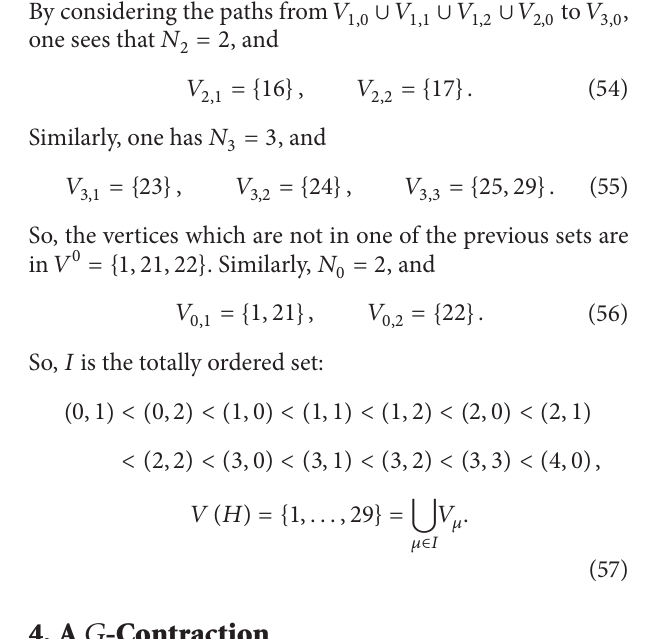
Also, for every 𝐶 ∈ 𝐶(𝐻) , there exists 𝜇 ∈ 𝐼 such that 𝑉(𝐶) ⊂ 𝜇, ] ∈ 𝐼 such that 𝜇 < ] , one has 𝑗 ∉ [𝑖] 𝑉 𝜇 . Moreover, for for every 𝑖 ∈ 𝑉 𝜇 , and 𝑗 ∈ 𝑉 ]